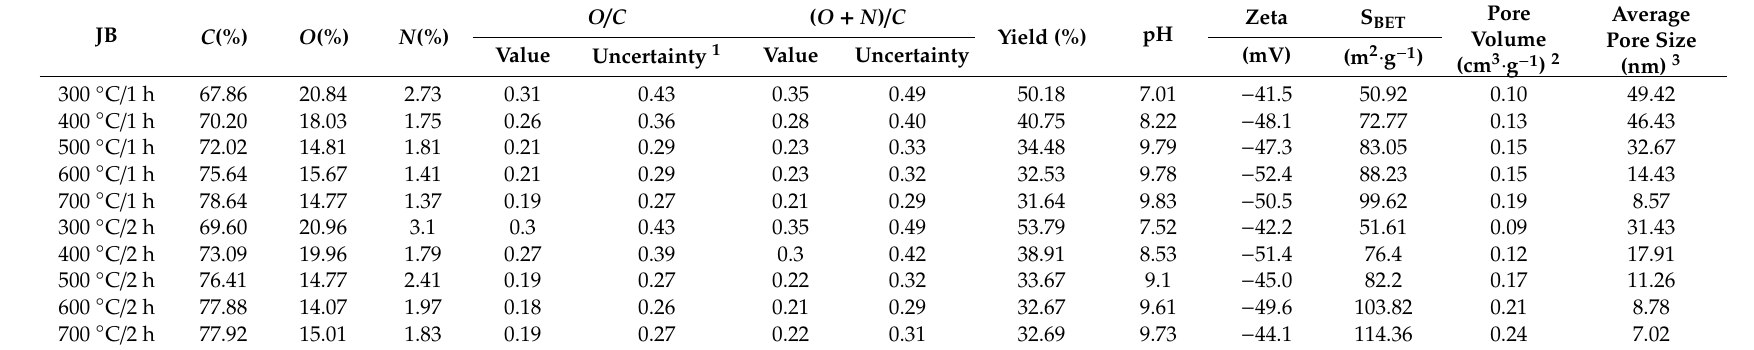
Table 3. Basic physicochemical properties of JB produced from jujube using the dry